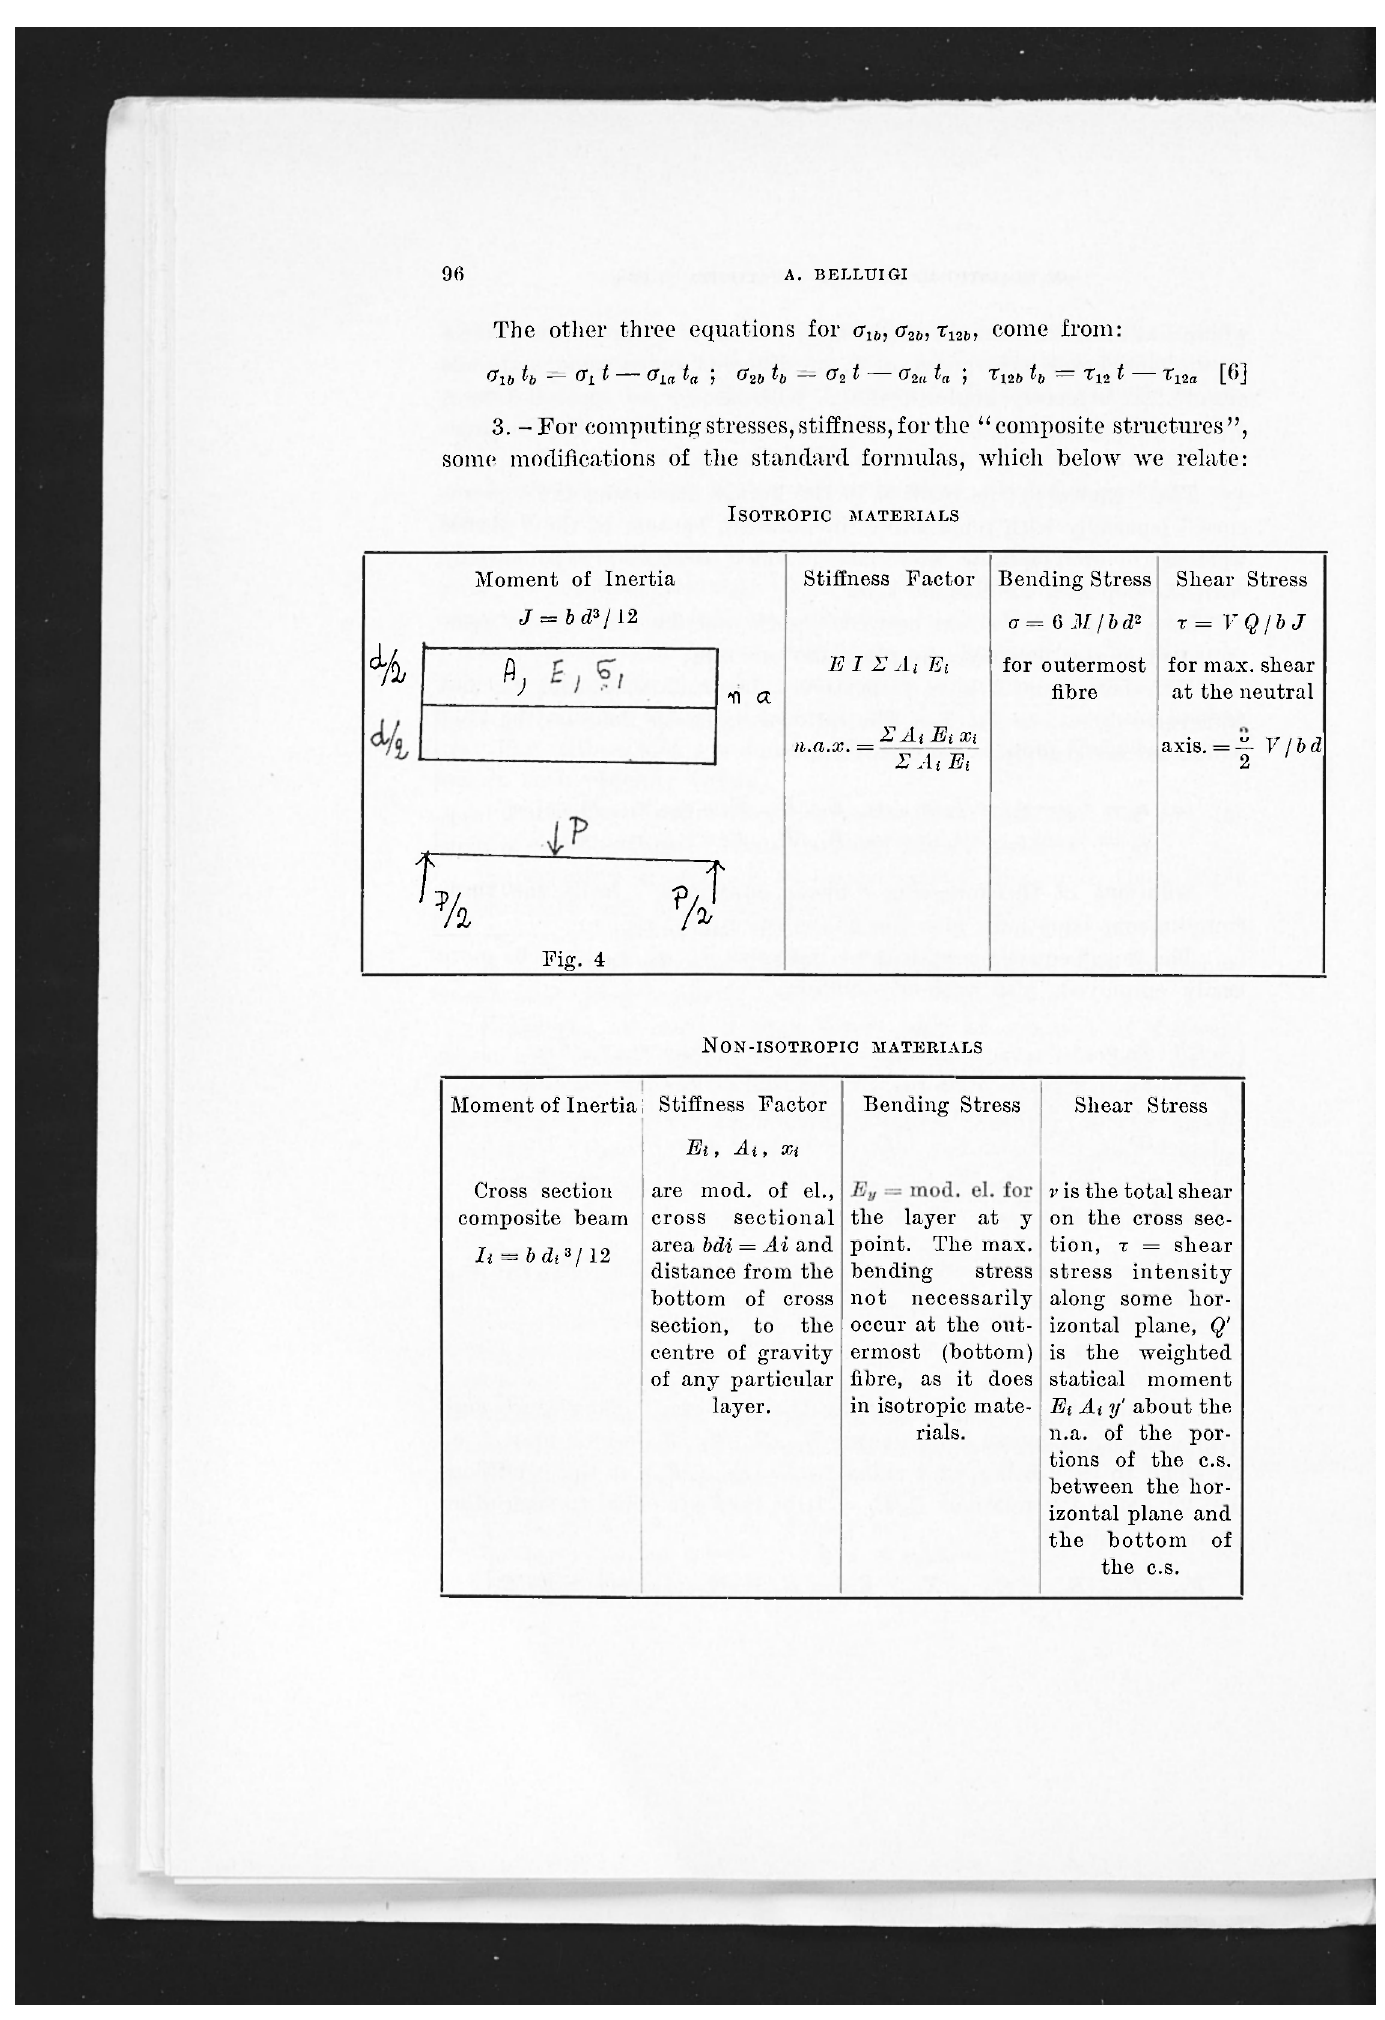
cross point. The max. tion, r = shear stress intensity bottom of cross along some hor- section, the izontal plane, Q' (bottom) is the weighted statical moment layer. Ei At y' about the rials. n.a. of the por- tions of the c.s. between the hor- izontal plane and the bottom of the